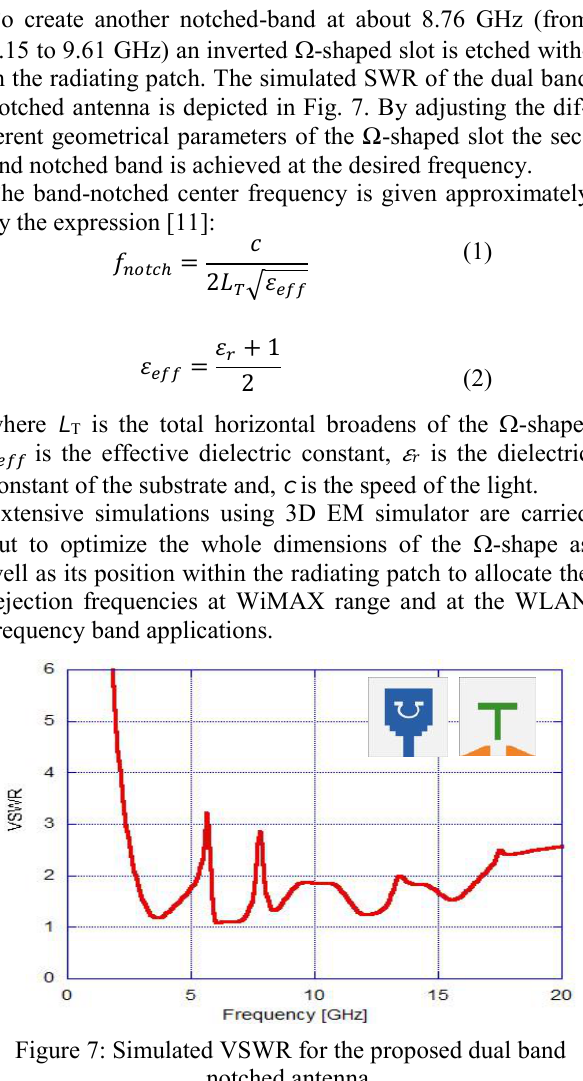
Figure 4: Simulated return loss, S 11 for various ground height L g values.